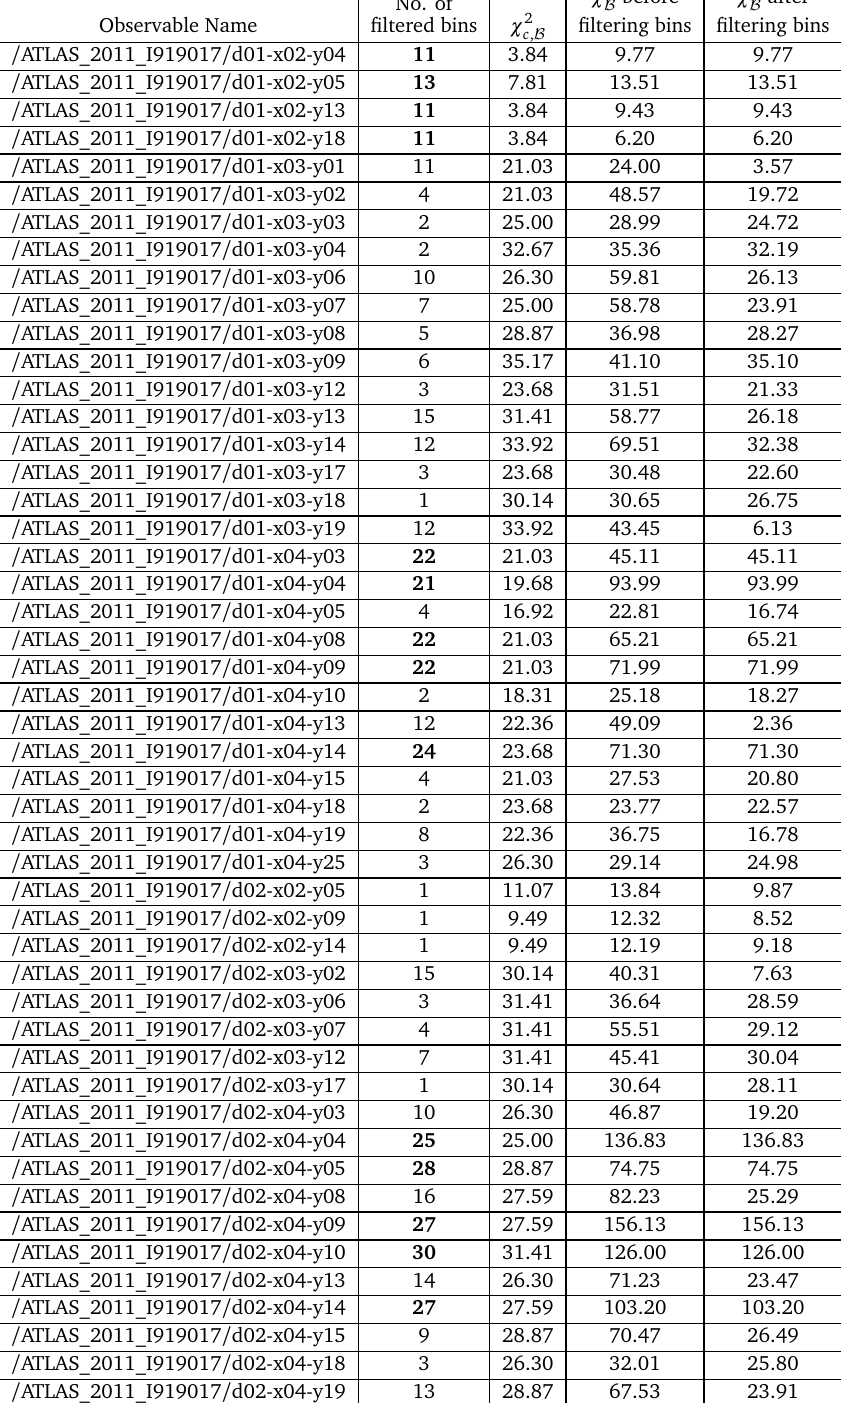
Table 19: Bin filtering of A14 data: Shown are the observables from which bins were removed and the number of bins removed. We also show the critical χ 2 values and the χ 2 test statistic before and after bin filtering. If all the bins were removed from the observable then the number of bins removed is shown in bold font and the χ 2 test statistic before and after bin filtering is the